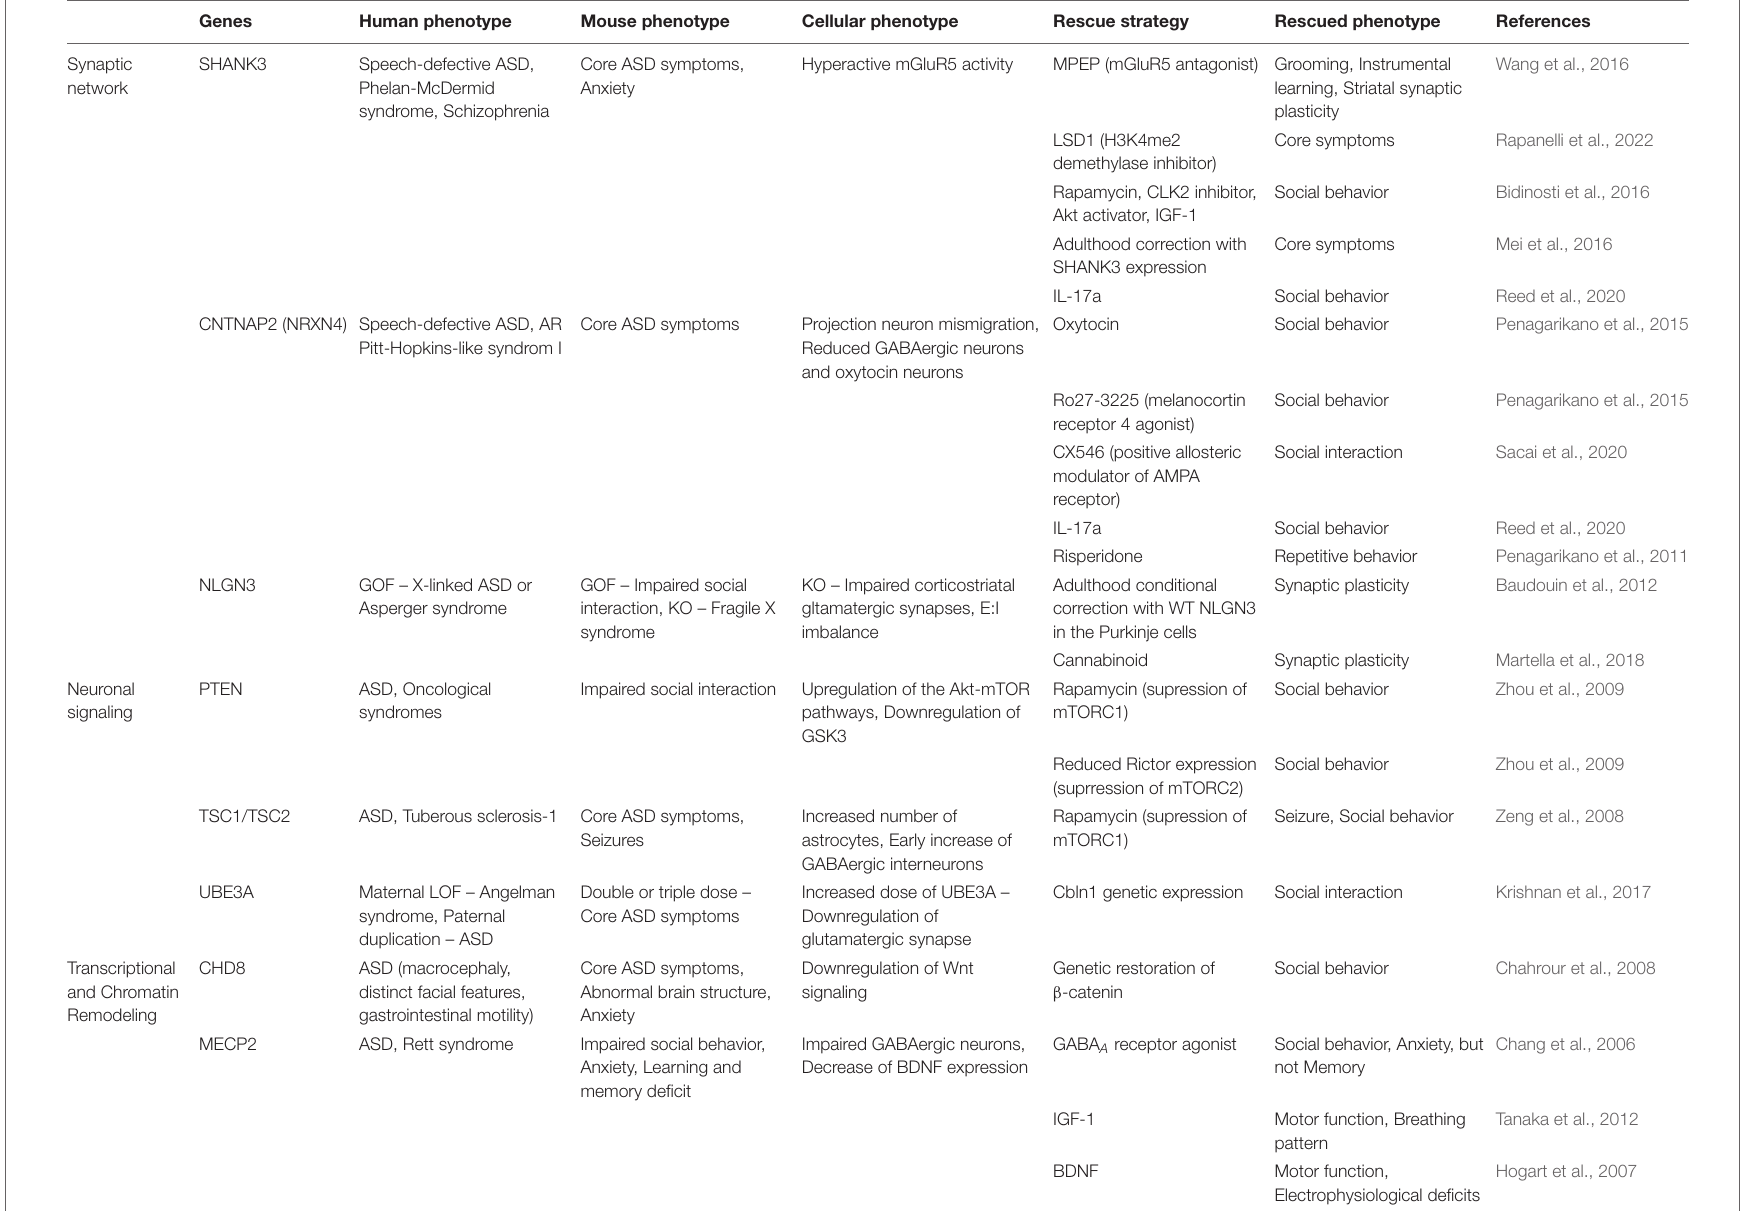
TABLE 1 | Patients’ phenotypes, as well as phenotypes and rescue strategies shown in ASD mouse